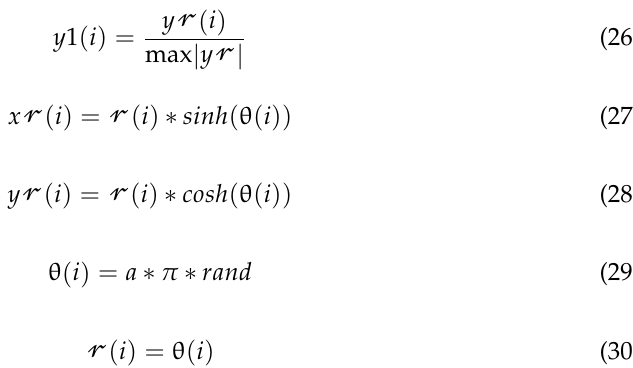
Figure 2. Hunting sequences adopted by the Bald Eagle Search. Swooping